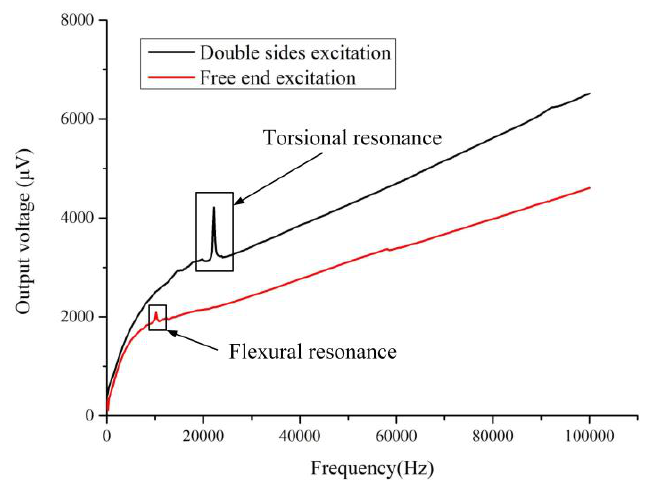
Figure 8. The output voltage of the Wheatstone bridge versus sweeping frequency under the two excitation methods.